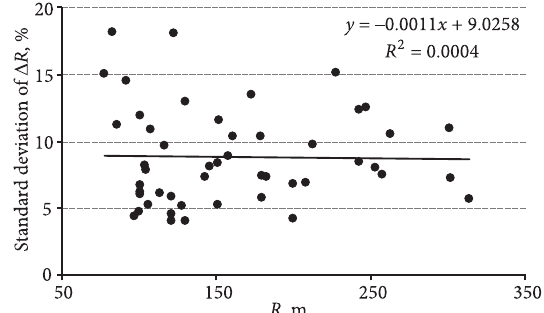
Fig. 3. The relationship between standard deviations of the percentage radii differences and curve radii